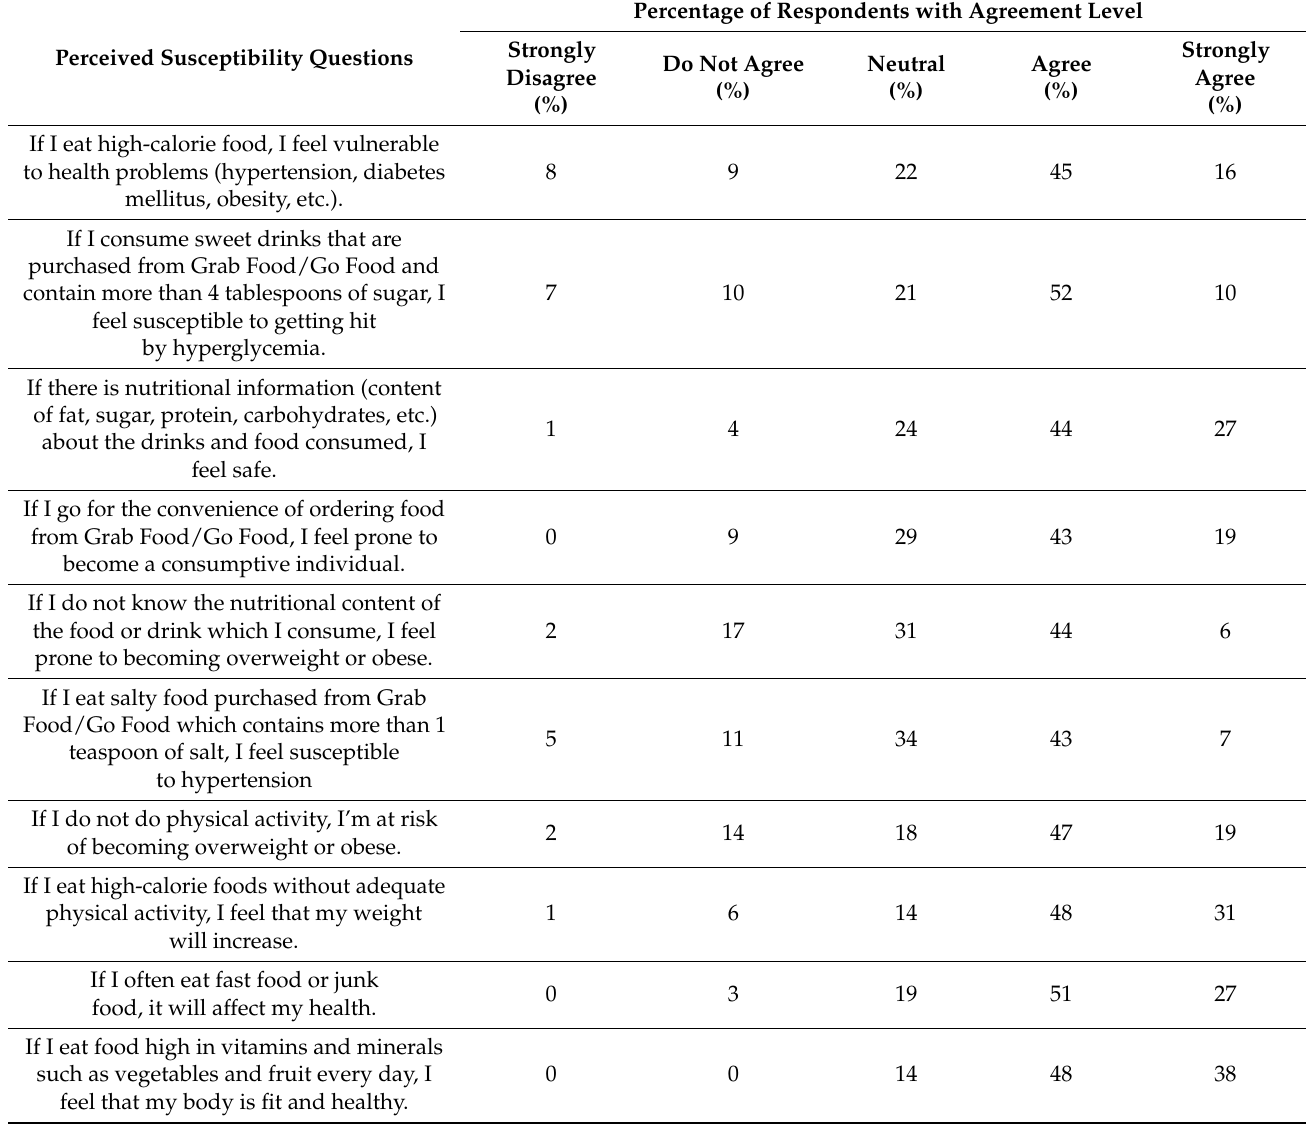
Table 4. Perceived susceptibility